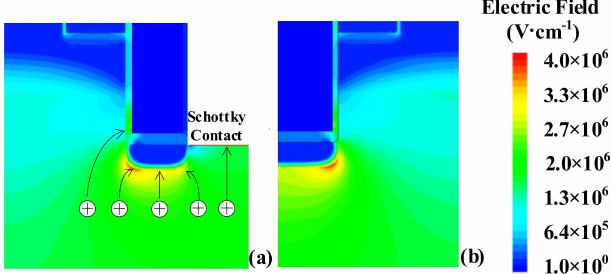
Figure 3. Electric field distribution of FS-TMOS ( a ) and C-TMOS ( b